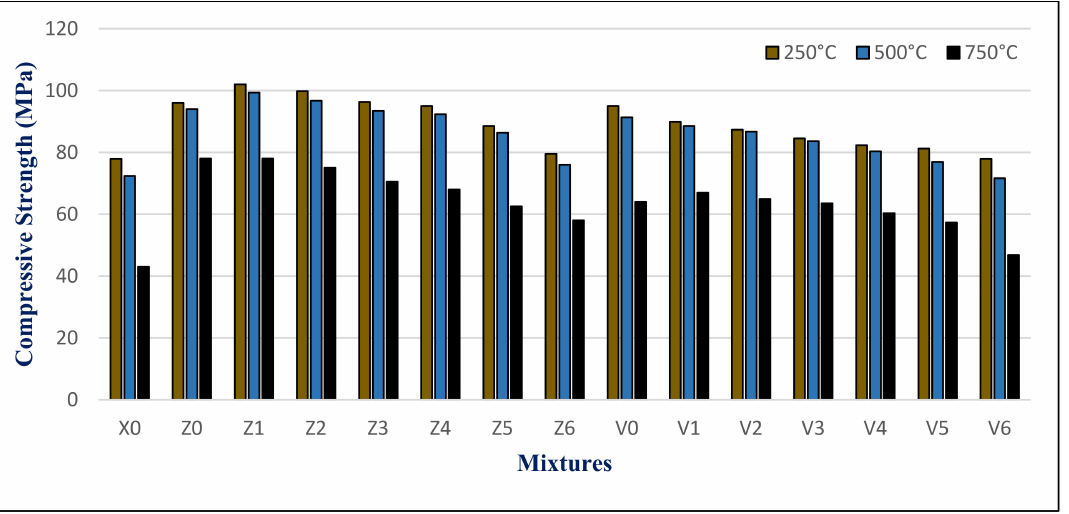
Figure 22. Groups Z and V strength results after exposure to elevated temperatures at 90 days.